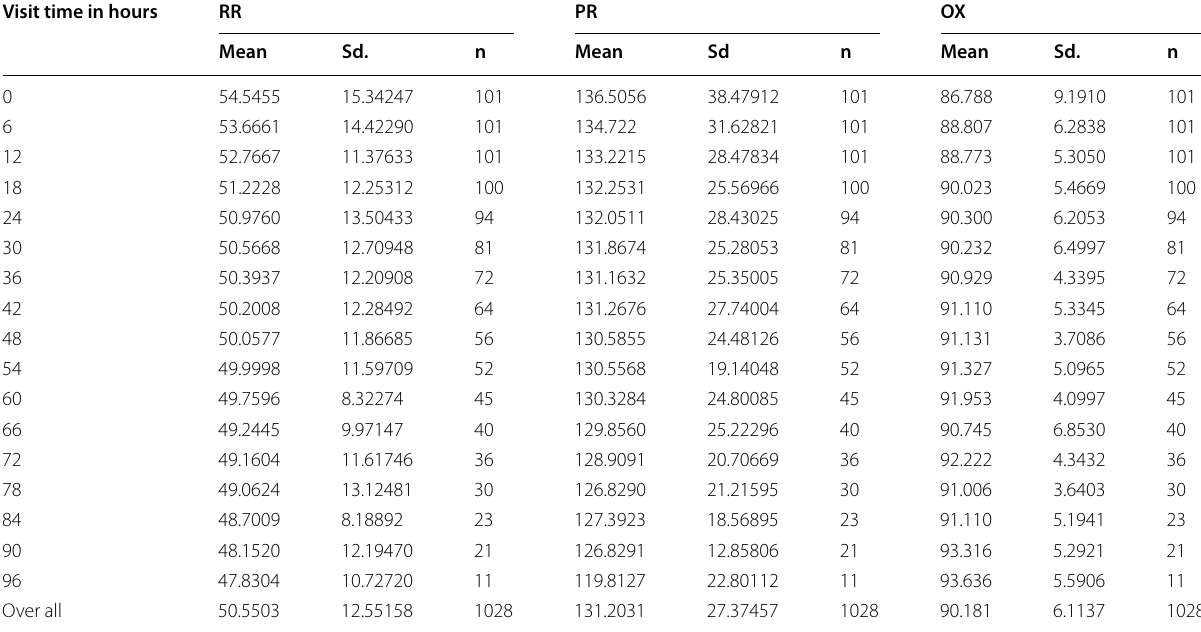
Table 2 The descriptive statistics of RR, PR and Oxygen saturation at each follow-up